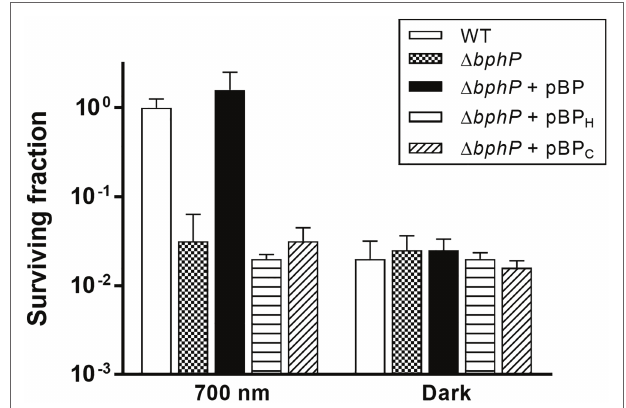
FIGURE 3 | Complementation of Δ bphP . Deinococcus radiodurans wild- type and bphP mutant strains harboring the bphP expression plasmids were spotted on TGY plates supplemented with 300 nM MMC. The pBP expresses the wild type DrBphP, and the pBP H and pBP C plasmids encode DrBphP H532A and C24A mutants, respectively. The plates were incubated under red light (700 nm) or no light (dark) conditions for 2 days prior to the enumeration of colonies. The surviving fraction was expressed relative to light-grown wild- type (WT) survival (arbitrarily set at 1). The error bars represent the SD of three independent experiments ( n =